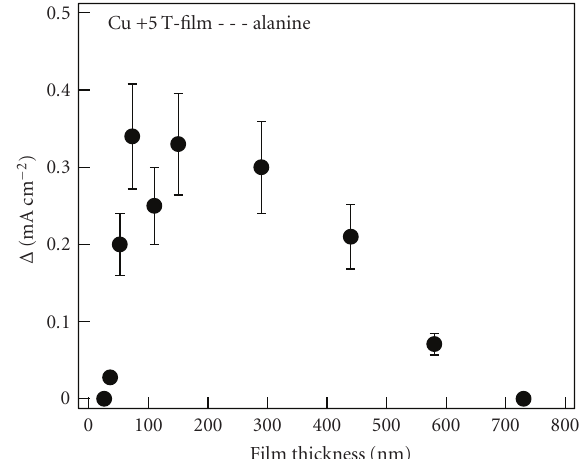
Figure 5: Film thickness dependence of the magnetoelectrochem- ical chirality. Δ is the peak current di ff erence between L- and D- alanines in the CVs on the Cu +5T-film